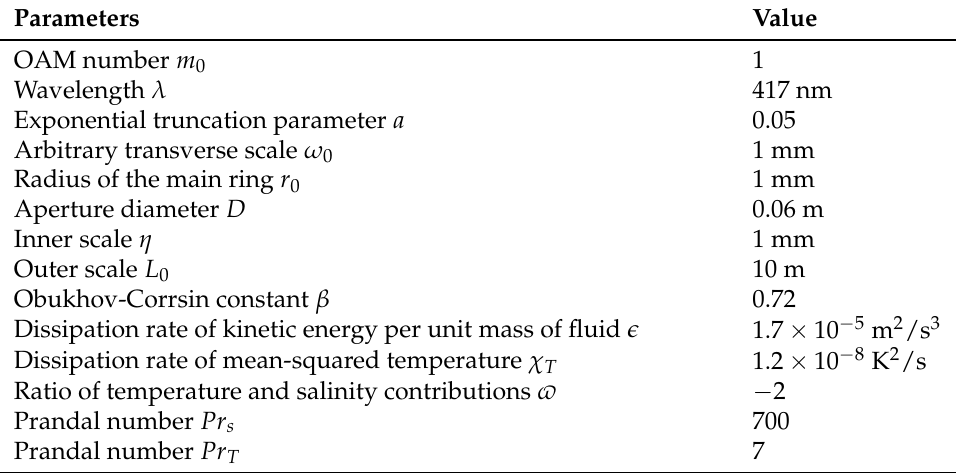
Table 1. Parameter values used in the